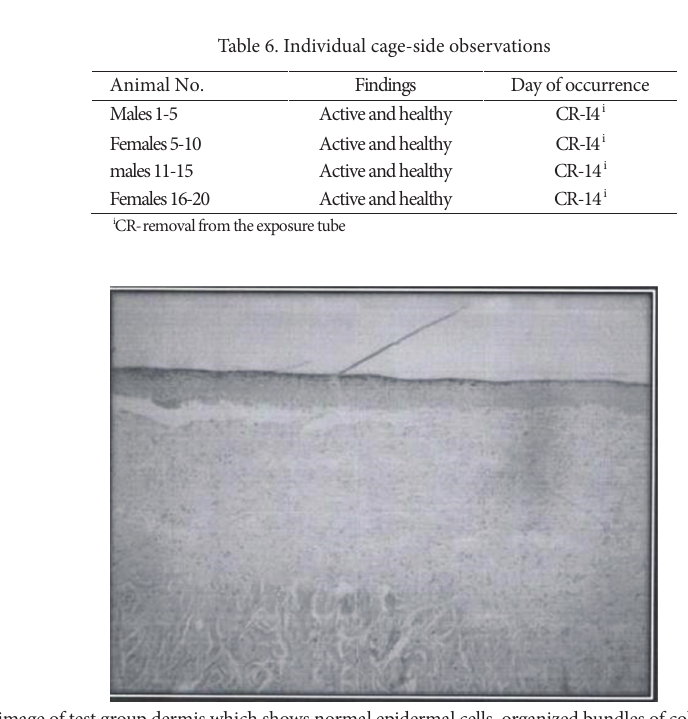
Genotoxicity, acute oral and dermal toxicity, eye and dermal irritation and corrosion and skin sensitisation evaluation of silver nanoparticles. Nanotoxicology, 2013. 7(5): 953-60. 5. Takenaka S, Karg E, Roth C, Schulz H, Ziesenis A, Heinzmann U, et al., Pulmonary and systemic distribution of inhaled ultrafine silver particles in rats. Environ Health Perspect, 2001. 109(Suppl 4):